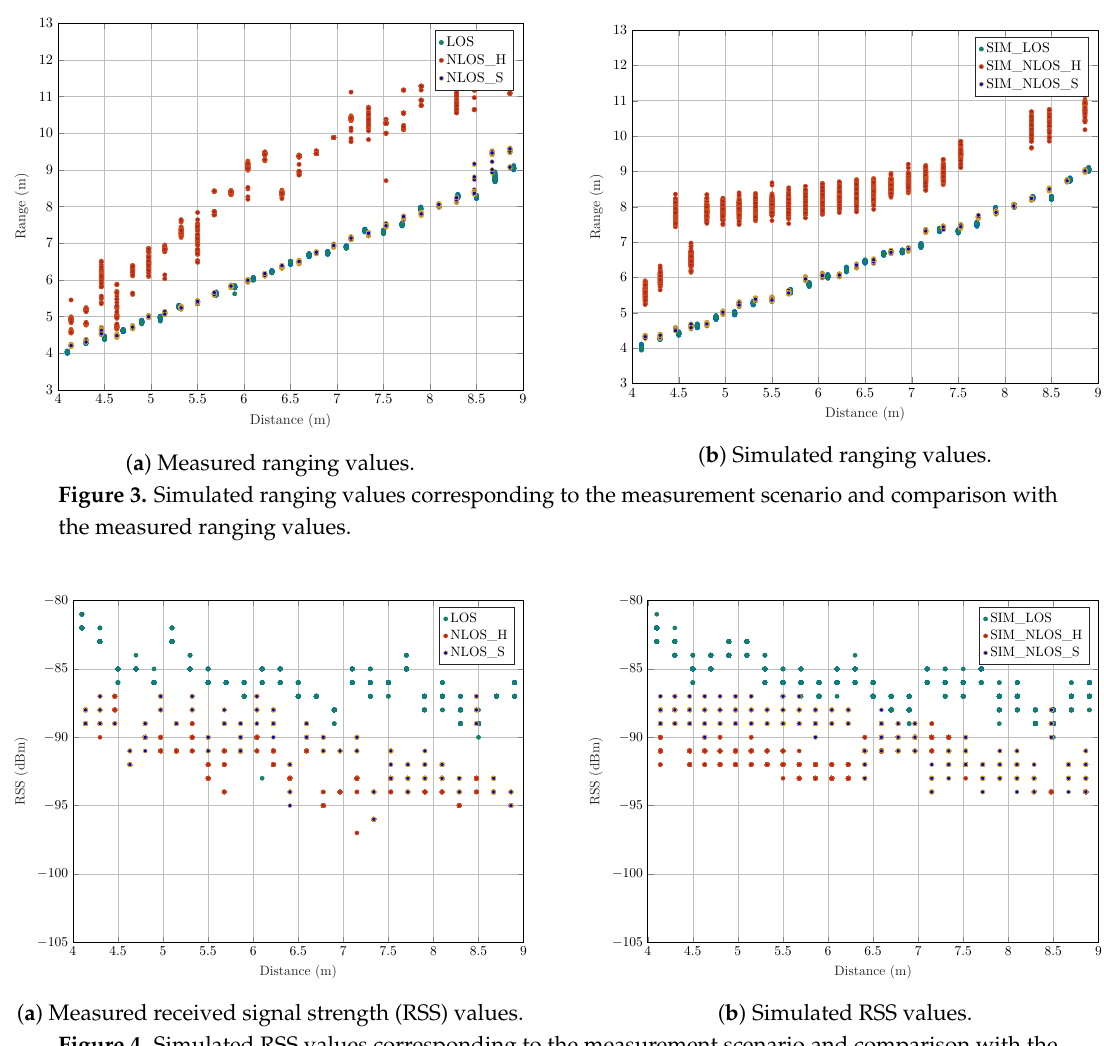
Figure 4. Simulated RSS values corresponding to the measurement scenario and comparison with the measured RSS values.